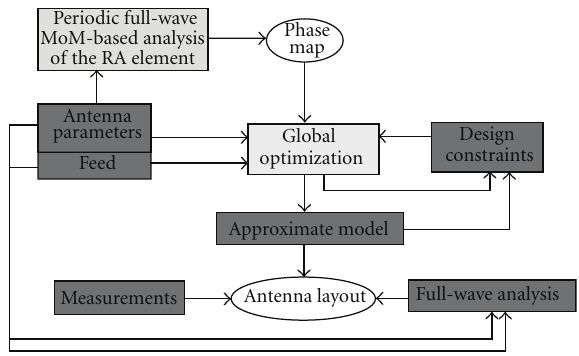
Figure 1: Block diagram of the proposed design